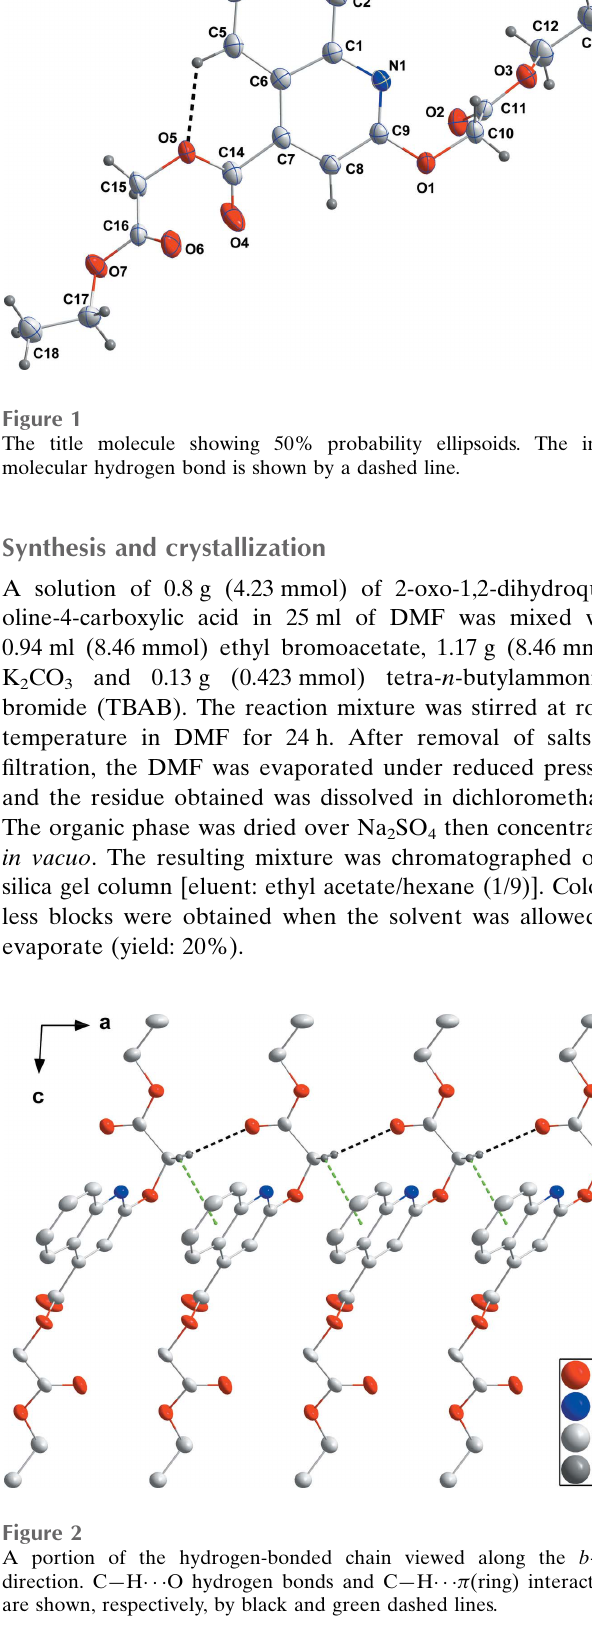
Table 1 Hydrogen-bond geometry (A˚ , (cid:2) ). Cg 2 is the centroid of the C1–C6 ring.